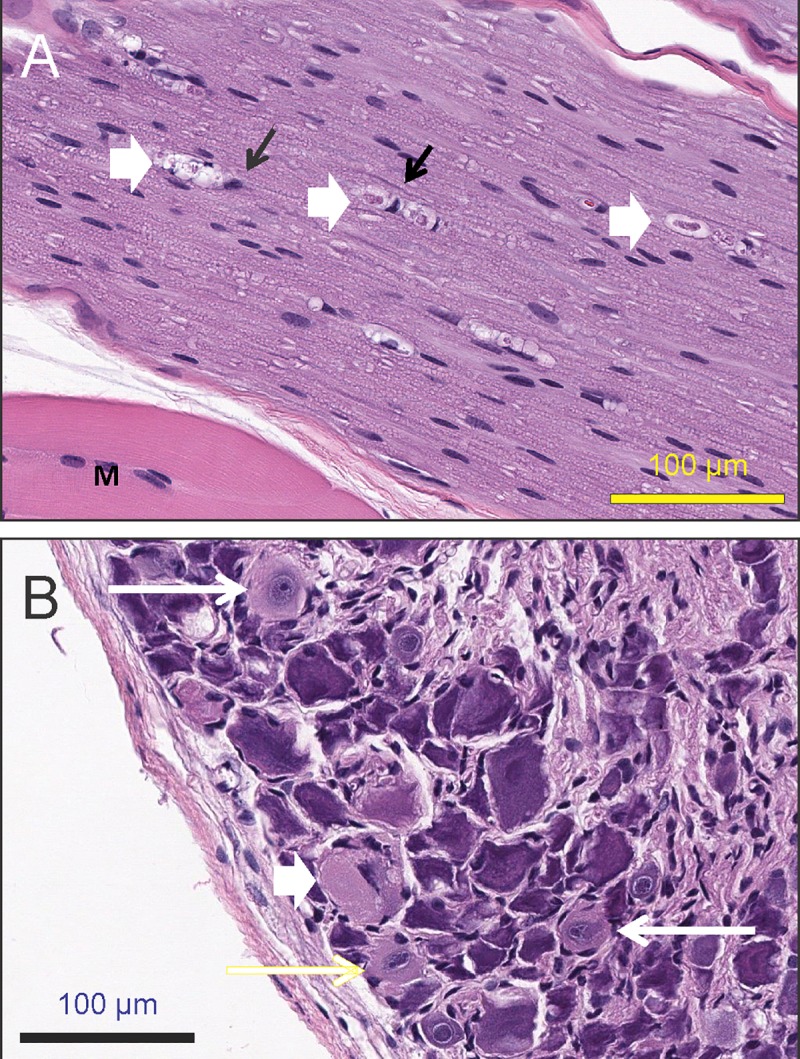
Microscopic findings of the nerve and DRG in JAX mice.(A) Nerve fiber degeneration and dilation of myelin sheaths containing eosinophilic granular material (digestion chambers, short white arrows) which are surrounded by enlarged Schwann cells (long black arrows). M: Skeletal muscle. (B) Neuronal degeneration and chromatolytic neurons. Note the dissolution of Nissl substance and displacement of the nucleus to the periphery of the cell (Short white arrow), and neurons undergoing early chromatolytic change. Note the eosinophilic granular appearance of the cytoplasm and accumulation of the Nissl substance near the enlarged nuclei (long white and yellow arrows).